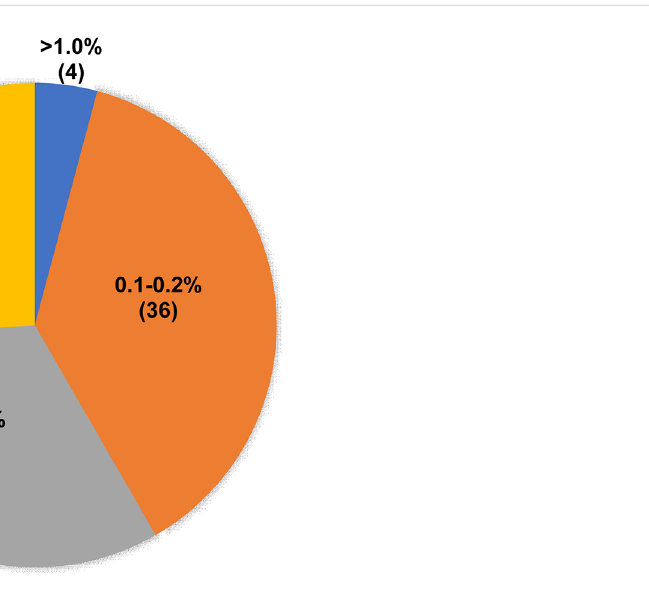
FIGURE 4 T790M mutation abundance of ddPCR T790M-positive but NGS T790M-negative samples. Pie chart showing the T790M abundance distribution of 96 ddPCR T790M-positive but NGS T790M-negative